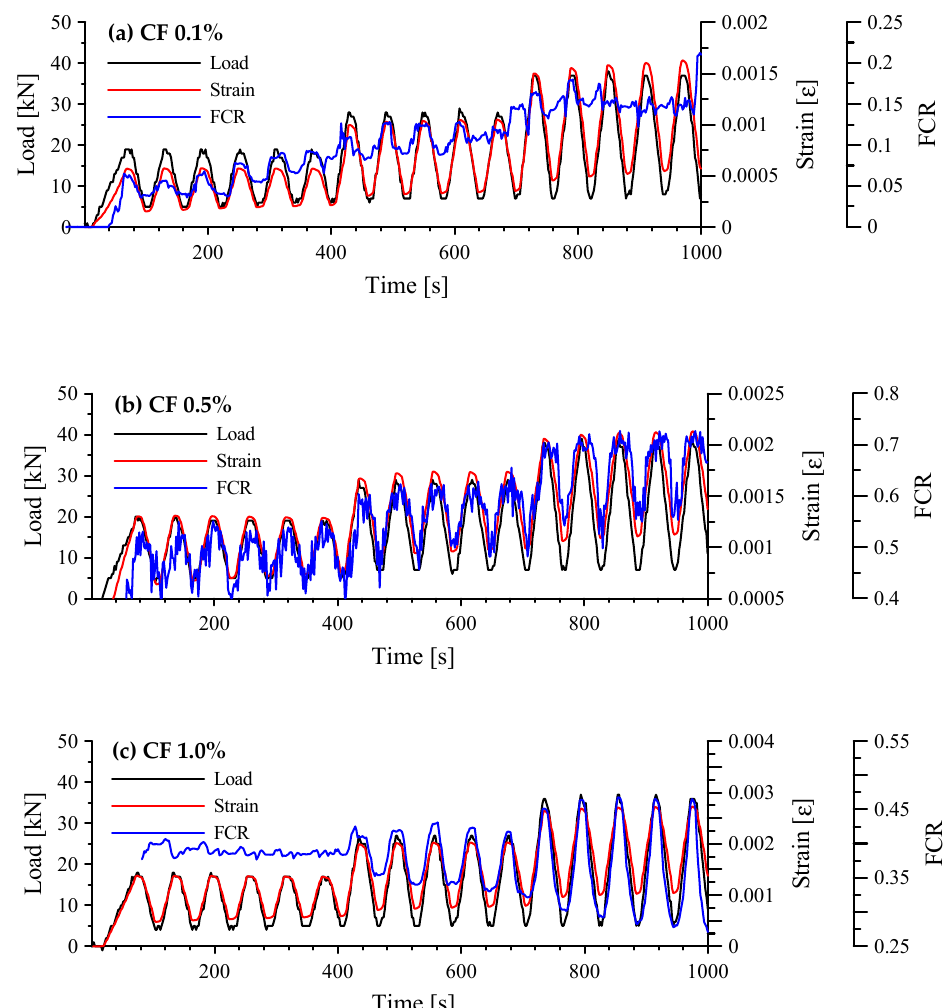
Figure 8. Responses of cement-based composites with 0.1, 0.5 and 1.0 vol.% CFs under cyclic compression; ( a ) composites with 0.1 vol.% CFs; ( b ) composites with 0.5 vol.% CFs; and ( c ) composites with 1.0 vol.% CFs.